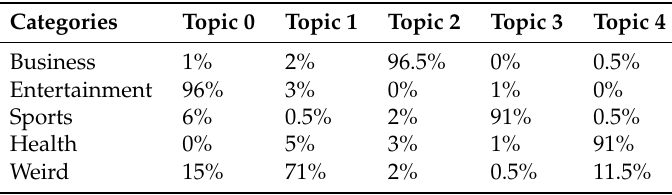
Table 6. Performance of LDA in labeling documents by using